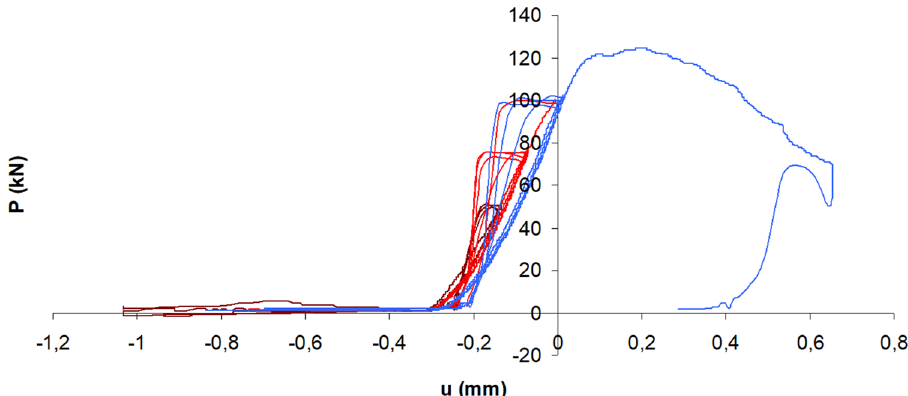
Fig. 4 Compressive tests of samples subjected to loading and unloading cycles: a low number of cycles; b medium number of cycles; c high num- ber of cycles